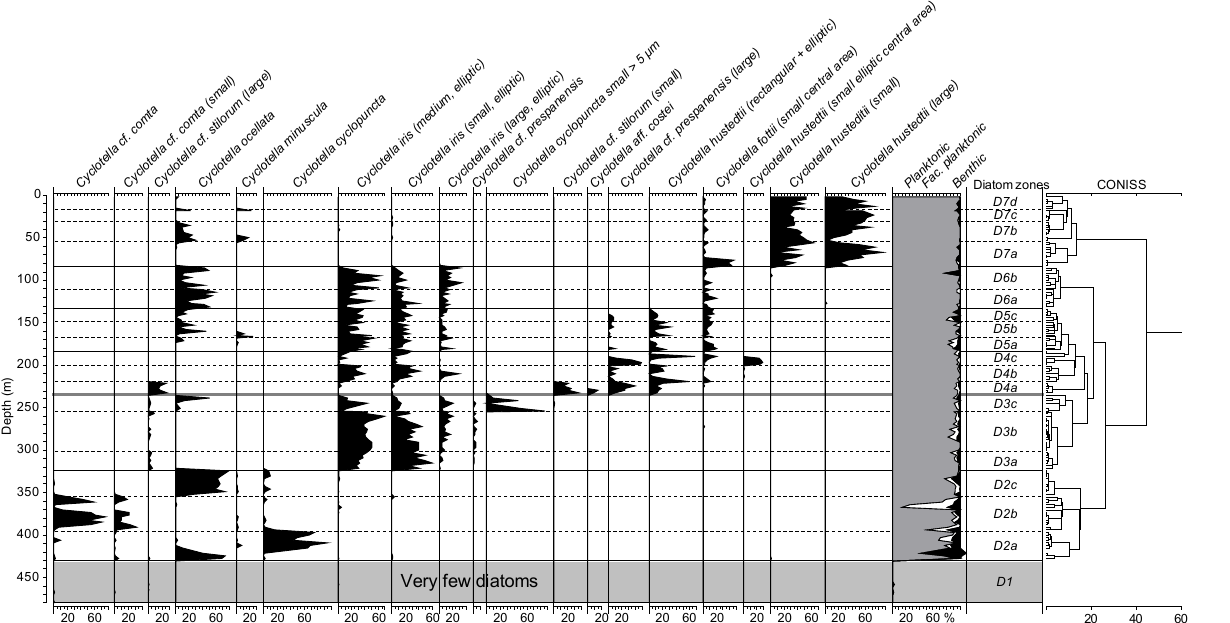
Figure 7. Preliminary diatom data from smear slides of core catcher samples (hole 1C, DEEP site).